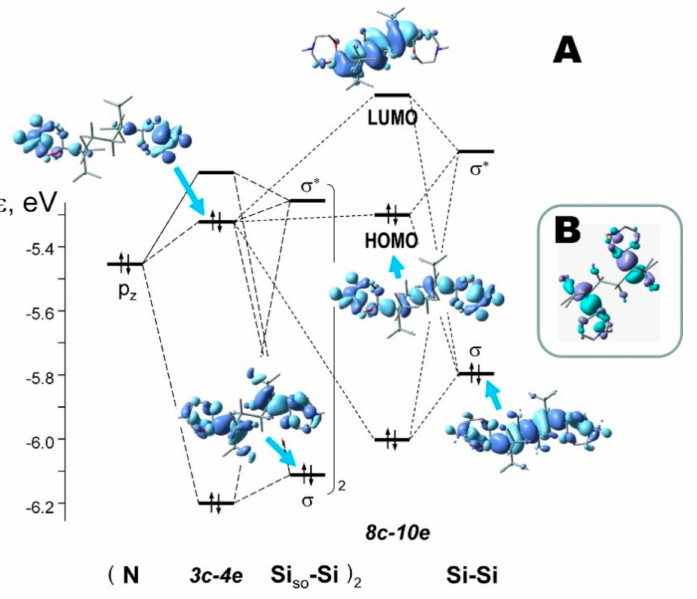
Figure 11. ( A ) Two 3c-4e systems of silocane units and resulting nonbonding 8c-10e HOMO in 5 from DFT B3LYP/aug-CC-pVQZ in acetonitrile (C-PCM). ( B ) For comparison, HOMO of 1,4- disilatranyltetrasilane, the Si 4 chain has the same orientation as in ( A ). Silocane 7 has several peculiar features. Second-order NBO perturbation analysis depicts the p z (N) → σ *(Si-Cl) delocalization as a hybrid bond NBO N → Si = 0.963( sp 4.49 ) N + 0.27( sp 1.31 ) Si with 1.87e population. Penta-coordination of Si in 7 (2 × ∠ O-Si-Cl eq + ∠ O- Si-O = 359.5 deg) and bond critical point bcp (3, − 1) found by AIM analysis in the N ... Si interatomic area (with ρ (r e ) = 0.0567 e Å − 3 and the Laplacian of electron den- sity ∇ 2 ρ (r e ) = 0.088 e Å − 5 ) complete the picture of the formation of the 3c-4e system in this